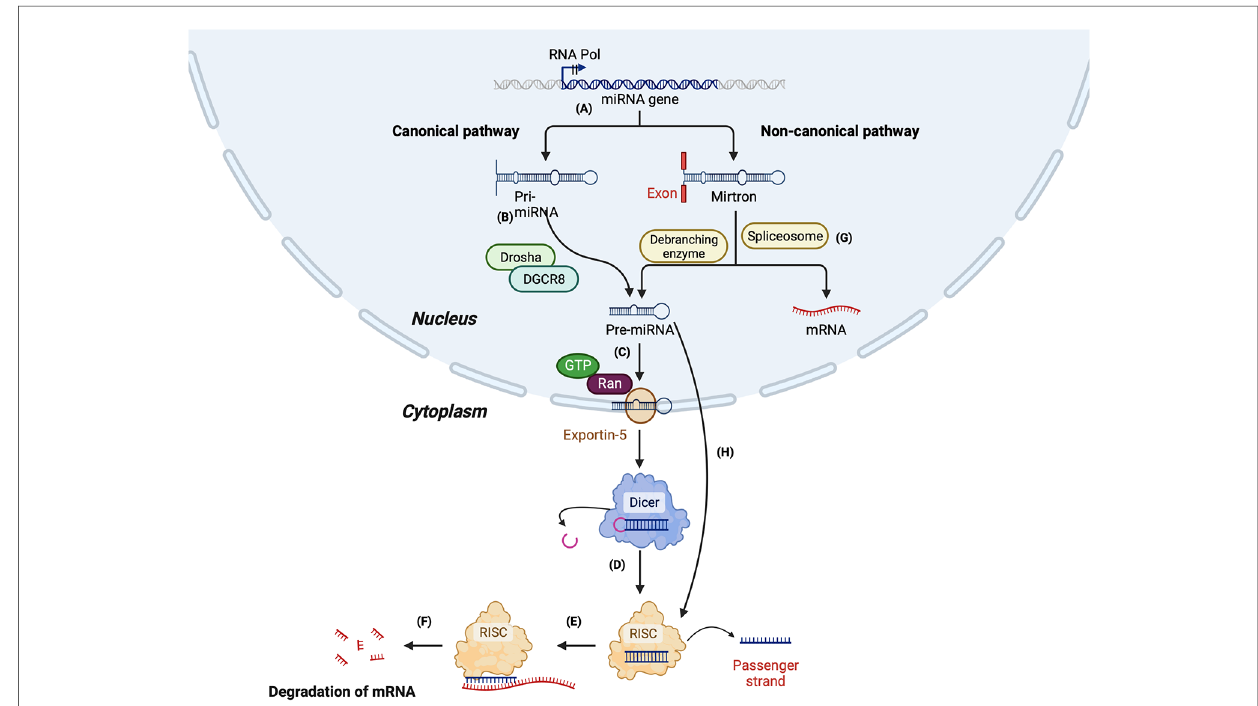
FIGURE 2 Summary of miRNA biogenesis via canonical and non-canonical pathway. Canonical pathway: ( A ) The miRNA gene is transcribed by RNA polymerase II to form a primary mi-RNA (pri-miRNA). ( B ) The pri-miRNA is cleaved by Drosha and Di-George syndrome critical region 8 (DGCR8) to form the precursor miRNA (pre-miRNA). ( C ) Pre-miRNA is transported to the cytoplasm by exportin-5. ( D ) In the cytoplasm, pre-miRNA is cleaved by Dicer to form a duplex mature miRNA. ( E ) The mature miRNA is loaded to RNA-induced silencing complex (RISC), leading to the cleavage of the passenger strand. ( F ) miR-RISC binds to the target mRNA leading to its degradation. Non-canonical pathway: ( G ) Synthesis of miRNA by Drosha/DGCR8 independent pathway: The primary miRNA is spliced by a spliceosome, forming a branched pre-miRNA. The pre-miRNA is debranched by a debranching enzyme, after which the synthesis is similar to the canonical pathway. ( H ) Synthesis of miRNA by Dicer-independent pathway: The pre-miRNA formed by the cleavage of pri-miRNA by Drosha/DGCR8 is exported to the cytoplasm. The pre-miRNA is not long enough to be processed by Dicer and forms the